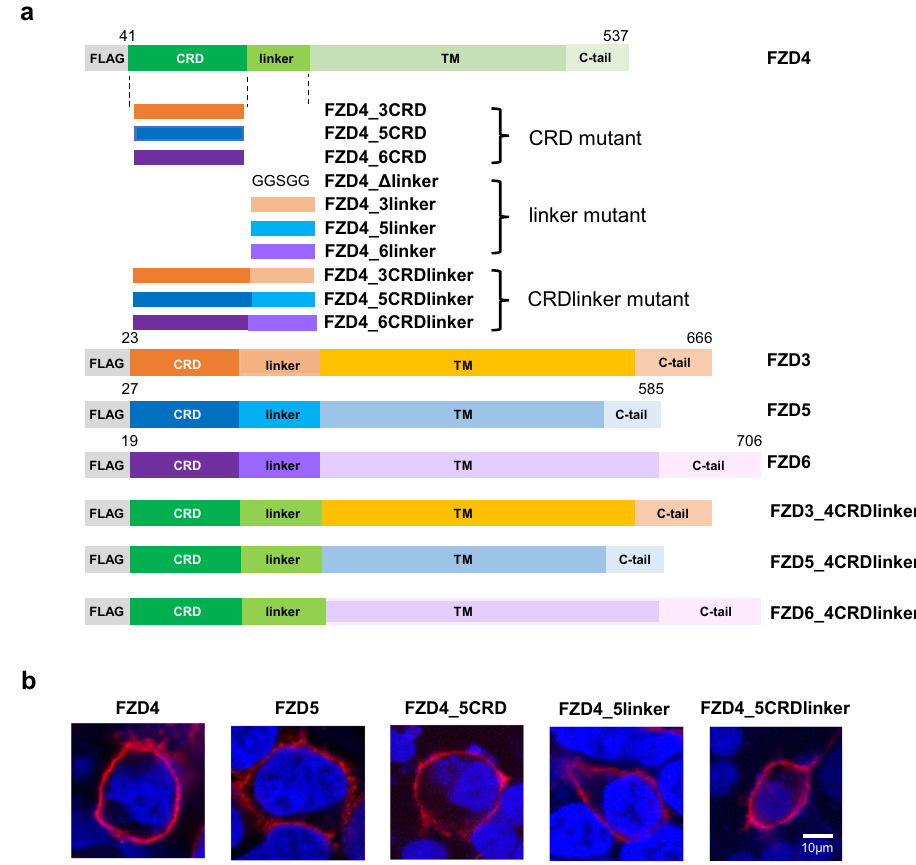
Fig. 1 Design of FZD mutant constructs and observation of surface expression. a Schematic representation of wild-type and various mutant constructs of FZD3, 4, 5, and 6. All constructs carry an N-terminus Flag tag. Numbers indicate amino acid numbering in the indicated FZD subtype. A complete list of FZD mutant constructs is given in Supplementary Table 1. b Surface expression of representative FZD4 mutant constructs was detected with anti-FLAG antibody (red) and nuclei was stained with Hoechst33342 (blue) (Scale bars: 10 µ m). Surface expression of various FZD mutants was analyzed with immuno fl uorescence assay, fl ow cytometry analysis, and surface ELISA assay (Supplementary Figs. 2 –